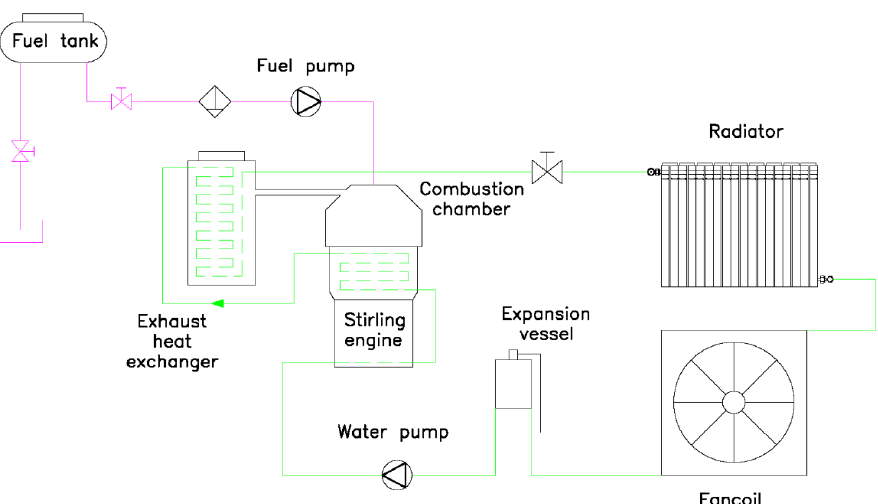
Figure 2. Schematic of the SE experimental